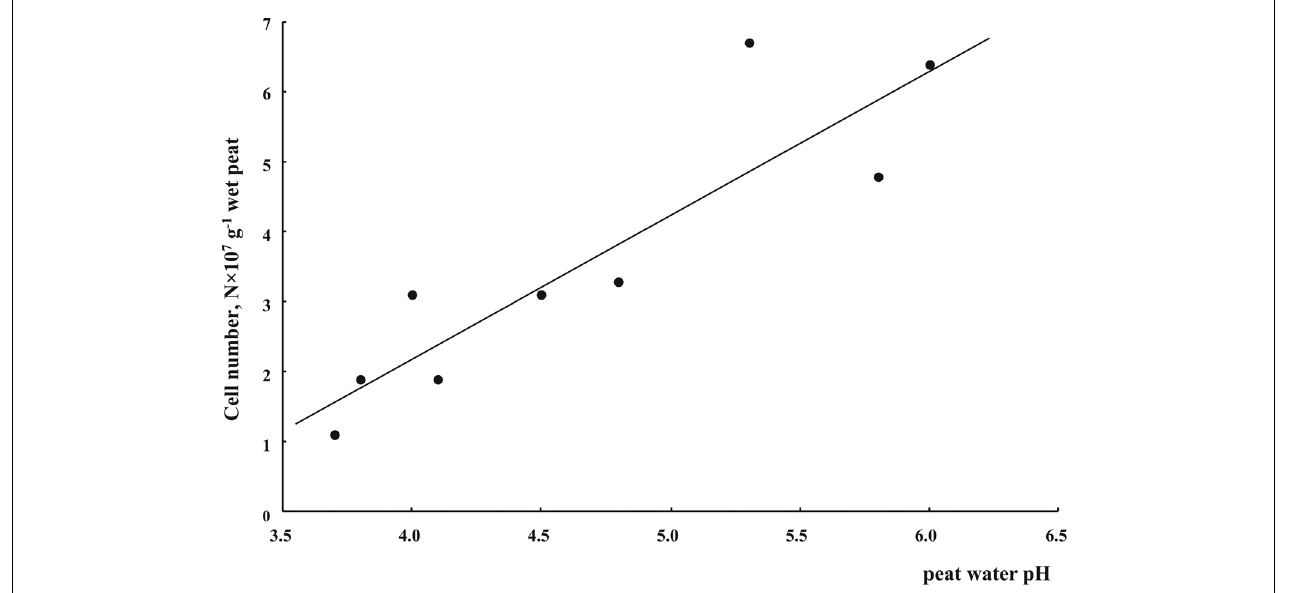
FIGURE 3 | Cell numbers of planctomycetes in oxic (0–10cm depth) Sphagnum peat as related to peat water pH.